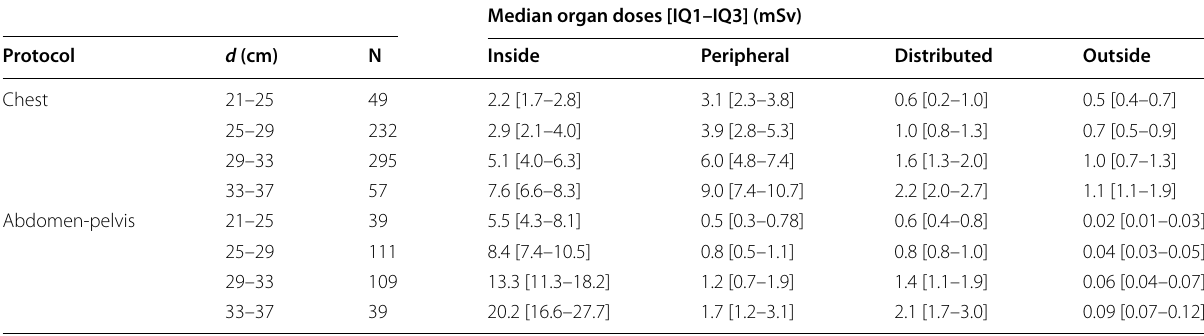
Table 3 Median values of the grouped organ doses and corresponding interquartile intervals for chest and abdomen-pelvis examinations. N represents the number of patients in the cohorts. The values are grouped according to the effective diameter